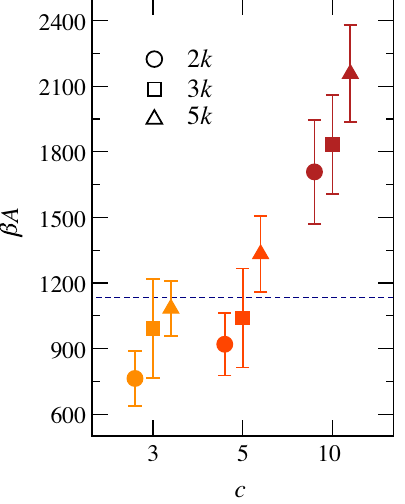
FIG. 5. Dependence of the 2D Hertzian strength A on the cross- linker concentration for microgels of various sizes. Values of β A are extracted via the theoretical calculation of Y and σ microgels assembled with N ≈ 2000 (circles), 3000 (squares), and 5000 (triangles) monomers for c ¼ 3% (orange), 5% (red), and 10% (dark red). Symbols are slightly displaced on the x axis to enhance readability. The dashed line indicates the approximate largest value of the Hertzian strength for which a reentrant transition could be observed (see Fig. 4). Data are averaged over four different topologies for each combination of N and c